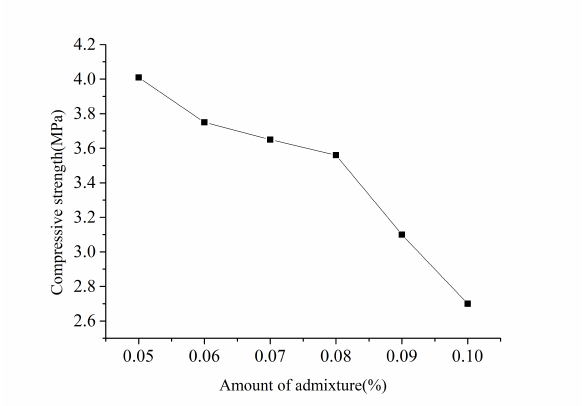
Figure 4: Compressive strength versus aluminum powder content